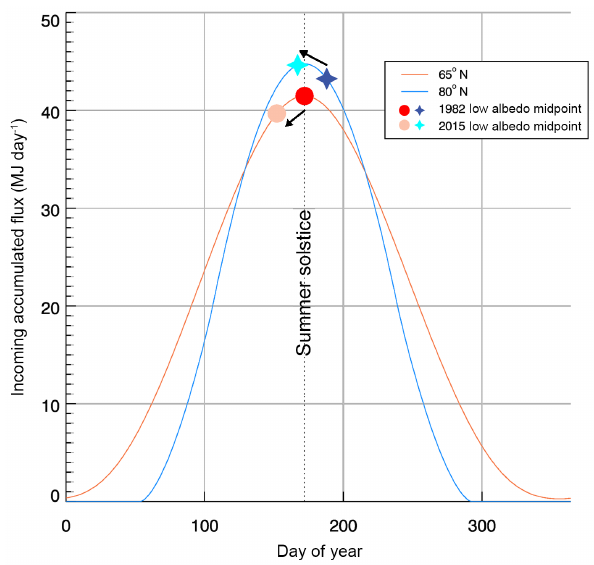
Figure 6. Accumulated top-of-atmosphere incoming shortwave flux for each day and for the 65 ◦ N (orange) and 80 ◦ N (blue) latitudi- nal bands, roughly representing the Arctic Ocean and Arctic land, respectively. Darker symbols represent the day of year that the mid- point trend in the low-albedo period (Fig. 5) was reached over land (circle) and ocean (star) in 1982, while lighter symbols show the day of year of the 2015 low-albedo period midpoint trend. Arrows clarify the direction in time for the change in the low-albedo period